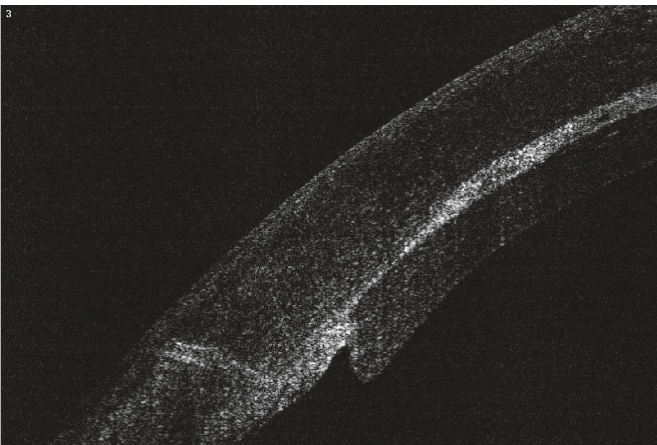
Figure 10: Another case with severe disparity between the posterior graft and the posterior corneal defect one month postoperatively.